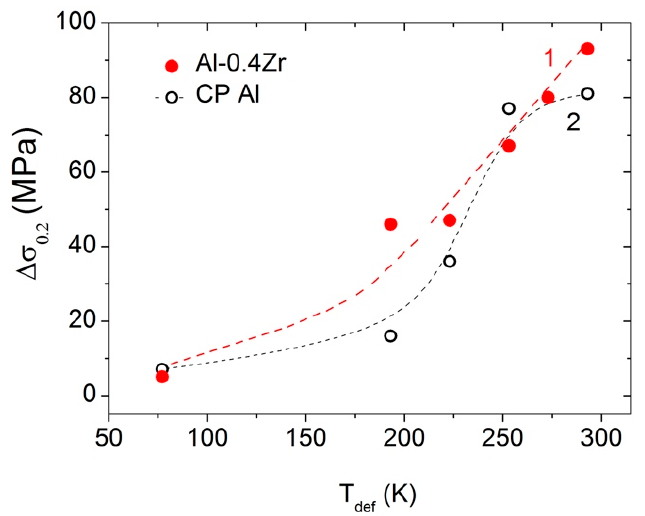
Figure 6. The annealing-induced yield stress increase ( Δ σ 0.2 ) versus the deformation temperature for the HPT-processed Al–0.4Zr alloy (curve 1) and HPT-processed CP Al (curve 2 plotted on the data of [13]).